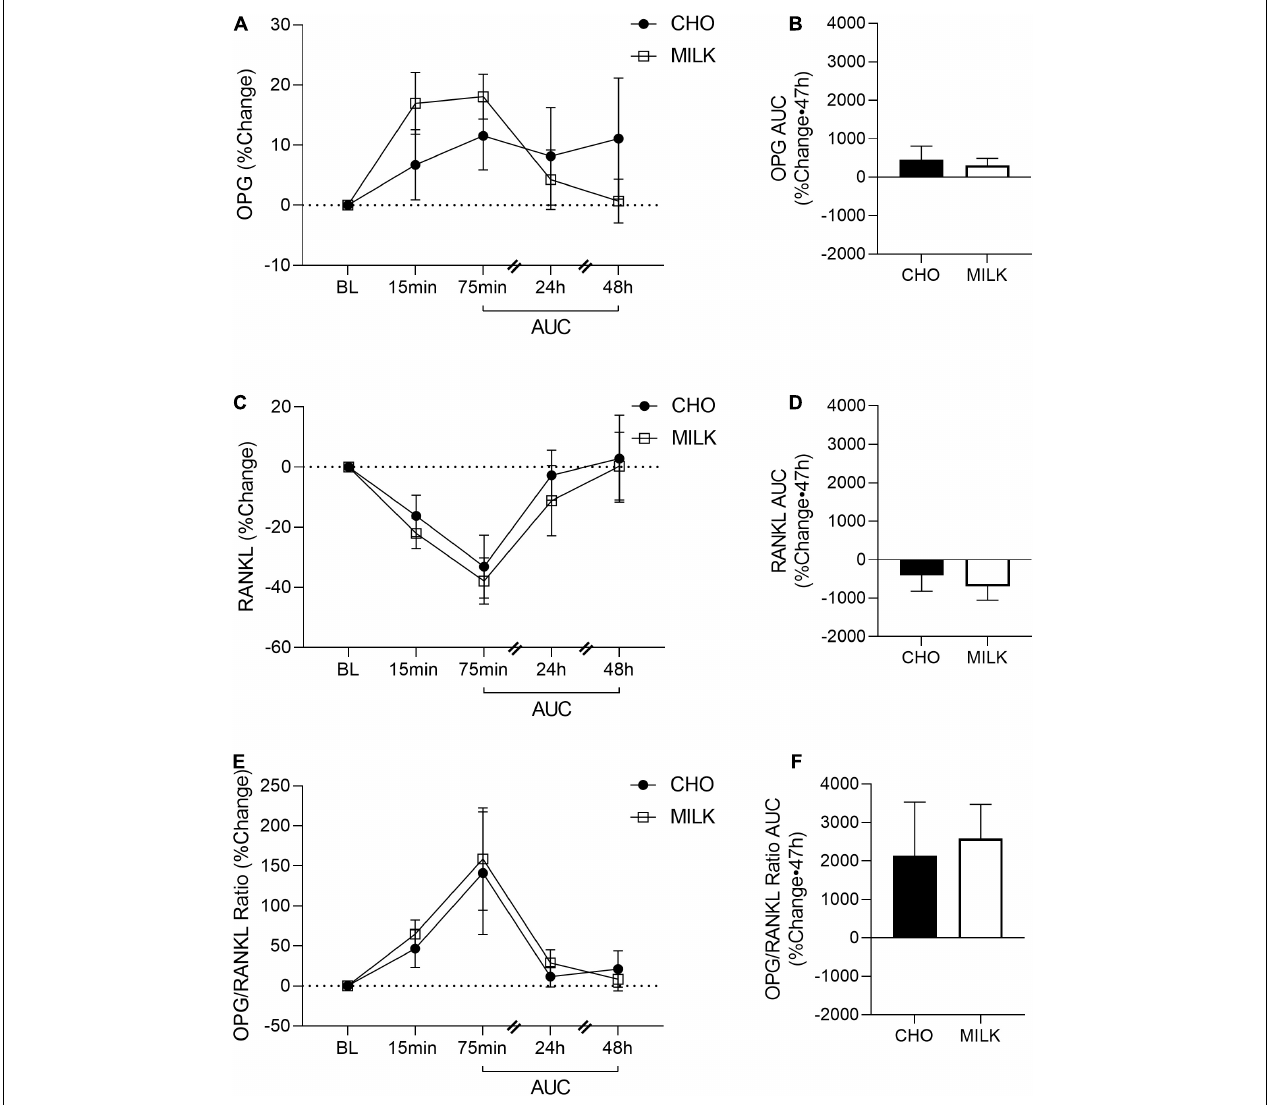
FIGURE 5 | Post-exercise percent change in osteoprotegerin (OPG; A ), receptor activator of nuclear factor-kB ligand (RANKL; C ) and OPG/RANKL ratio (E) and area under the curve from 75-min to 48-h for OPG (B) , RANKL (D) and OPG/RANKL ratio (F) in the CHO and MILK trials. Values are means ± SEM. OPG and RANKL ( n = 12); OPG/RANKL ratio ( n = 11). BL, baseline; AUC, area under the curve.